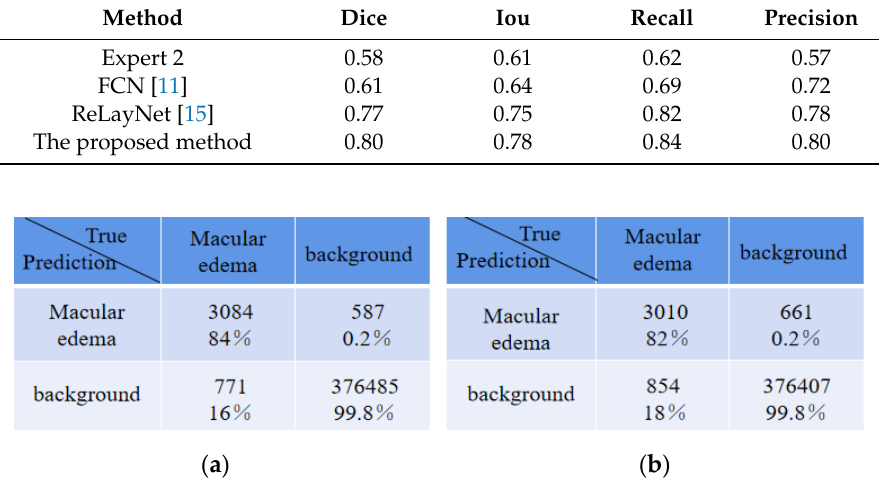
Figure 8. Quantitative comparison of confusion matrices: ( a ) proposed method; ( b ) ReLayNet.